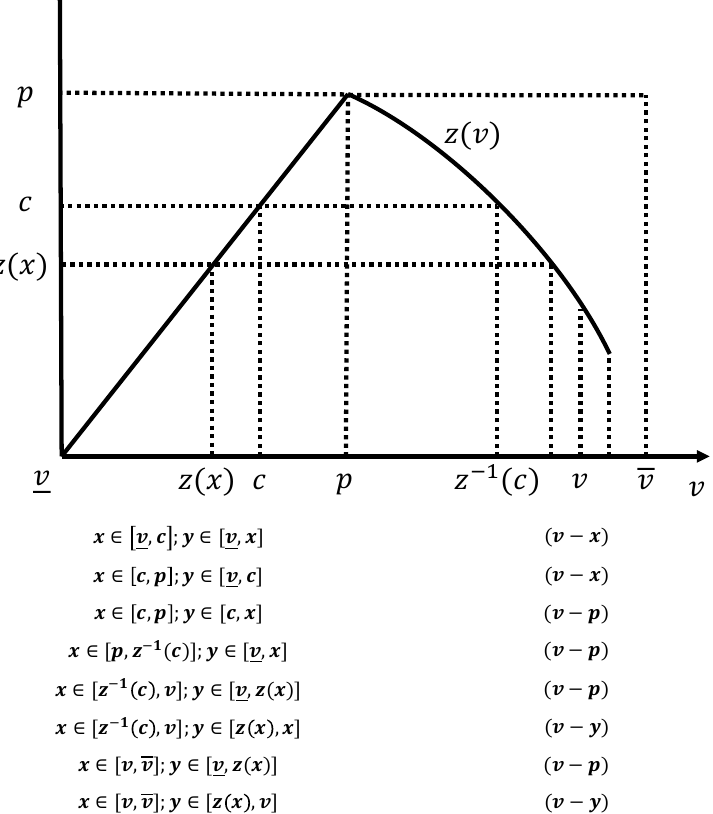
( 𝒗𝒗 − 𝒚𝒚 ) Figure 1. Equilibrium bidding functions 7